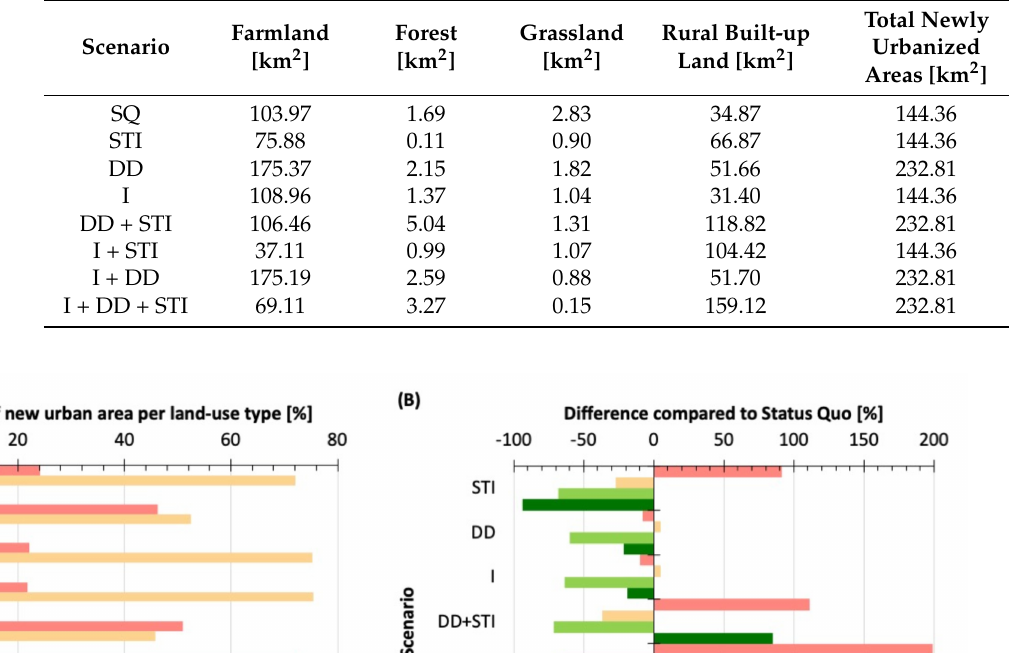
Table 4. Calculated consumption areas during transition in square kilometers for all scenario simulations.